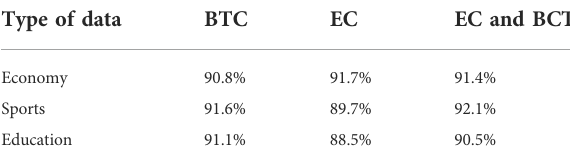
TABLE 2 Evaluation of different performances of the